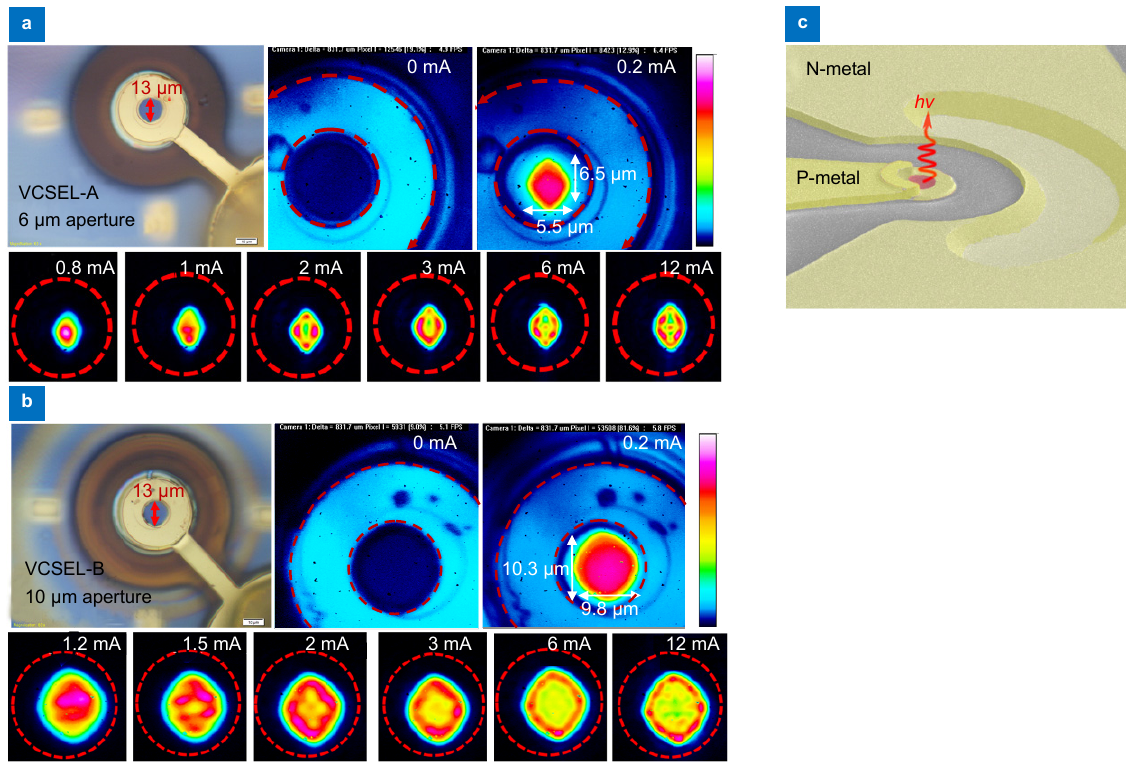
Fig. 6 | Near field lateral modal distributions of the VSCELs with ( a ) 6- μ m and ( b ) 10- μ m oxide confined apertures under different bias current conditions and ( c ) Cross-sectional SEM image of the VCSEL.